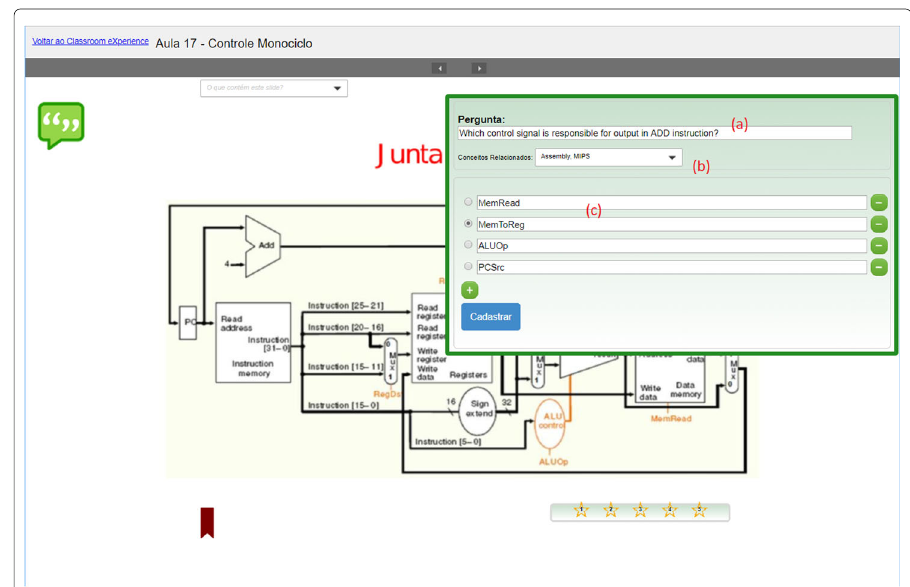
Fig. 3 Screenshot for registering a quiz in the CX environment. The instructor defines the quiz text (a), the associated BN topics (b), and the answer alternatives (c), including selecting the correct one